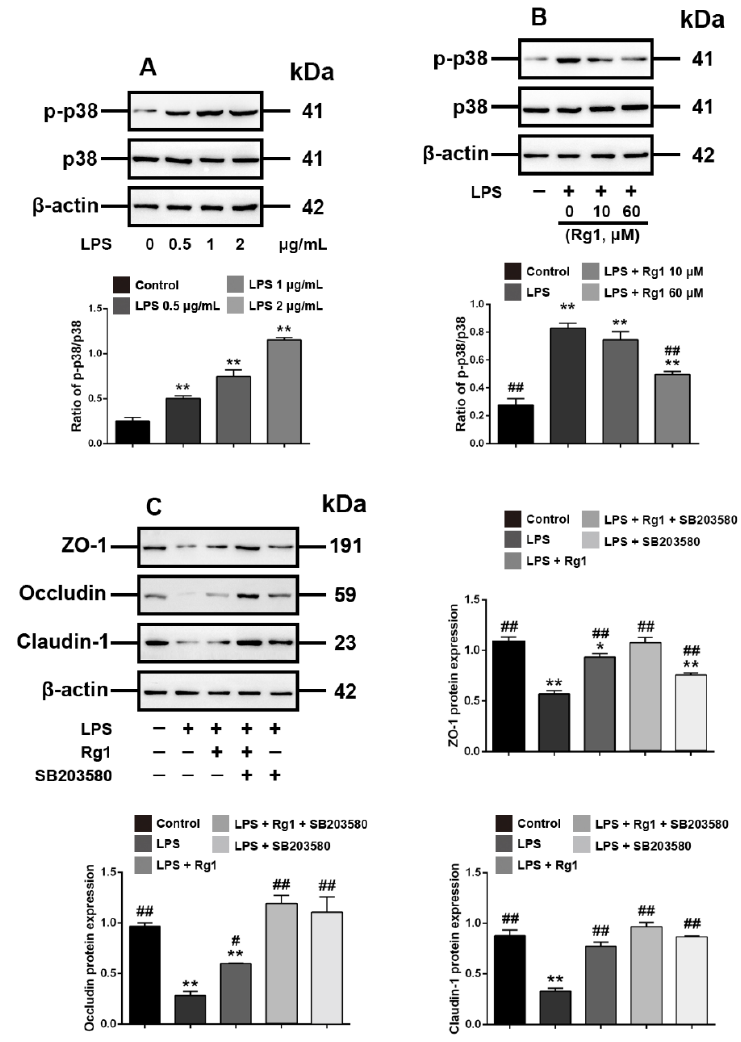
Figure 3. Interference with p38 MAPK signaling is associated with Rg1 inhibition of LPS-induced tight junction disruption in IPEC-J2 cells in vitro. IPEC-J2 cells were treated with vehicle and LPS at the indicated concentrations for 48 h. ( A ) Western blot analyses of p38 MAPK signaling molecules. IPEC-J2 cells were treated with vehicle, LPS (2 µ g/mL) and Rg1 at the indicated concentrations for 48 h; ( B ) Western blot analyses of p38 MAPK signaling molecules. IPEC-J2 cells were treated with vehicle, LPS (2 μ g/mL), SB203580 (10 μ M), and Rg1 (60 μ M) for 48 h; ( C ) Western blot analyses of tight-junction-related proteins. β -Actin was used as an invariant control for equal loading. Blots are representative of three independent experiments with densitometry showing the mean ± s.d. * p < 0.05 versus control and ** p < 0.01 versus control. # p < 0.05 versus LPS and ## p < 0.01 versus LPS.